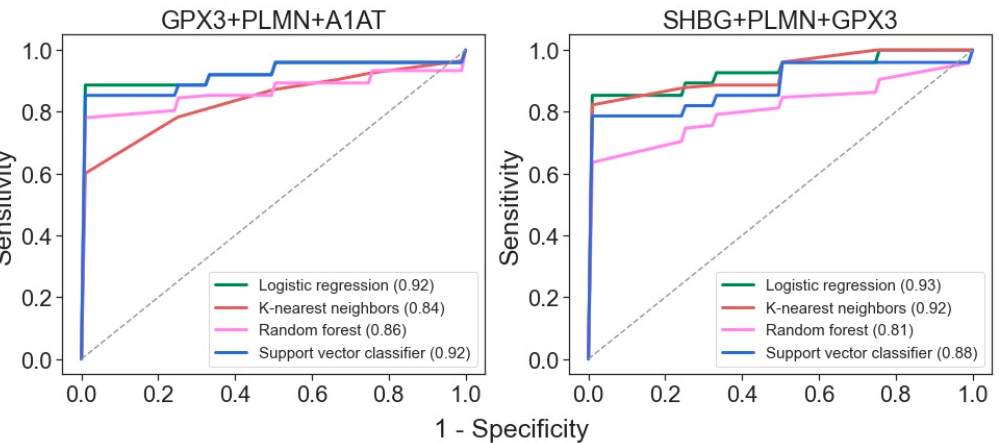
Figure 4. ROC curves for differentiation of glomerulopathies with mild and severe disease states for classifiers generated with the 4 algorithms using the 3-protein sets. AUC values are indicated in